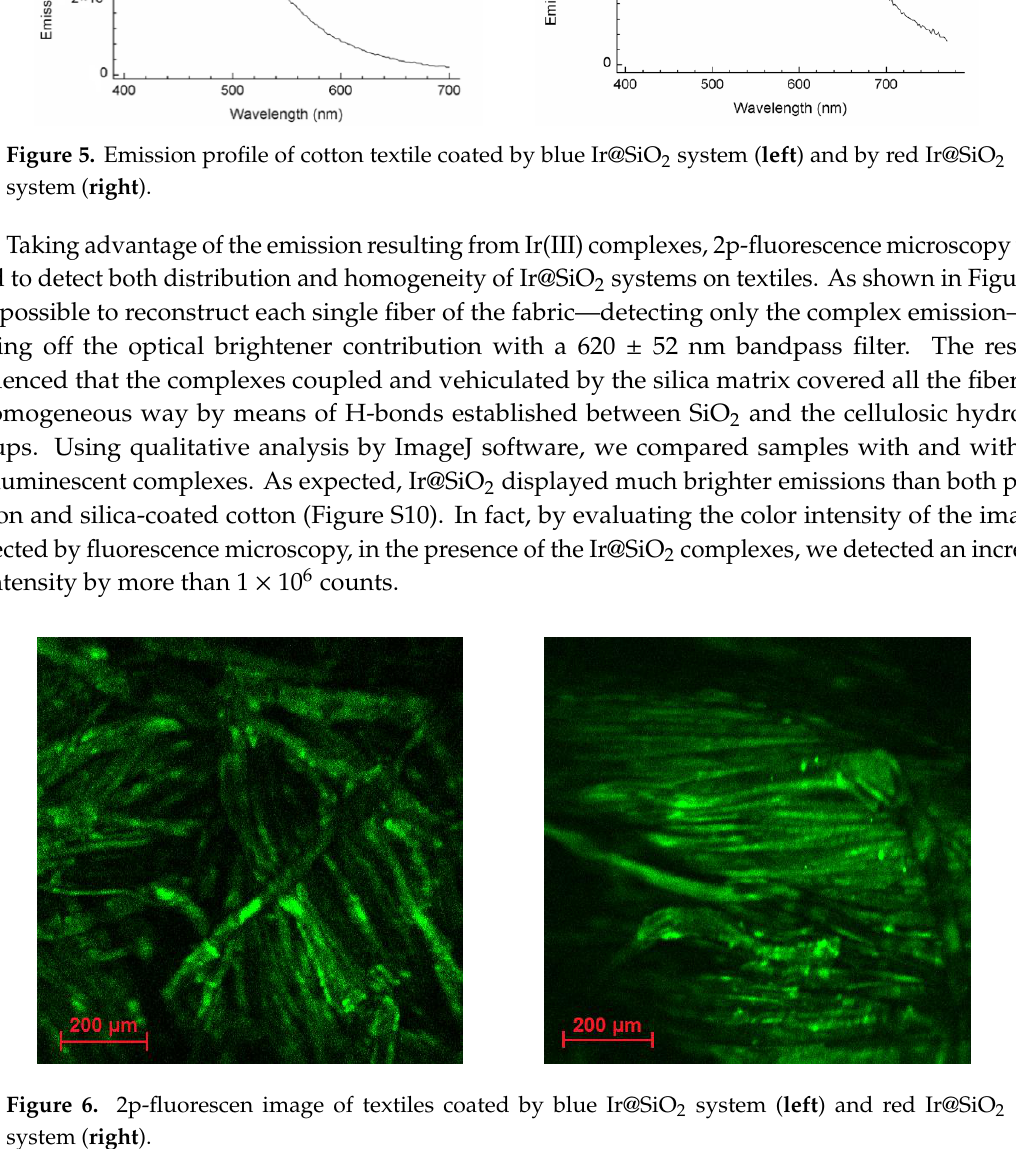
Figure 5. Emission profile of cotton textile coated by blue Ir@SiO 2 system ( left ) and by red Ir@SiO 2 system ( right ).